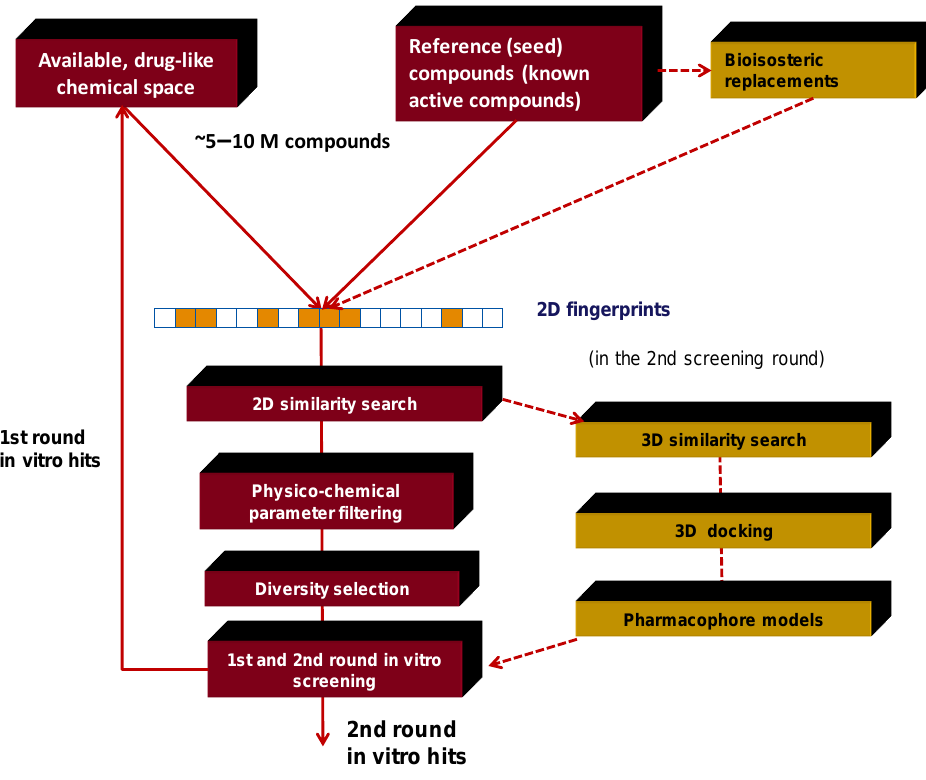
Figure 2. Typical work-flow for multistep virtual screening approach combined with in vitro screening.